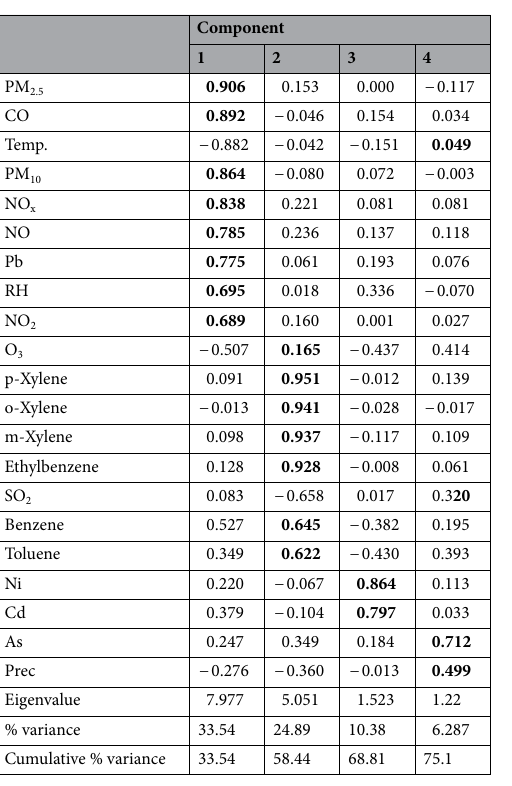
Table 3. PCA rotated component matrix of the studied air pollutants. Significant values are in